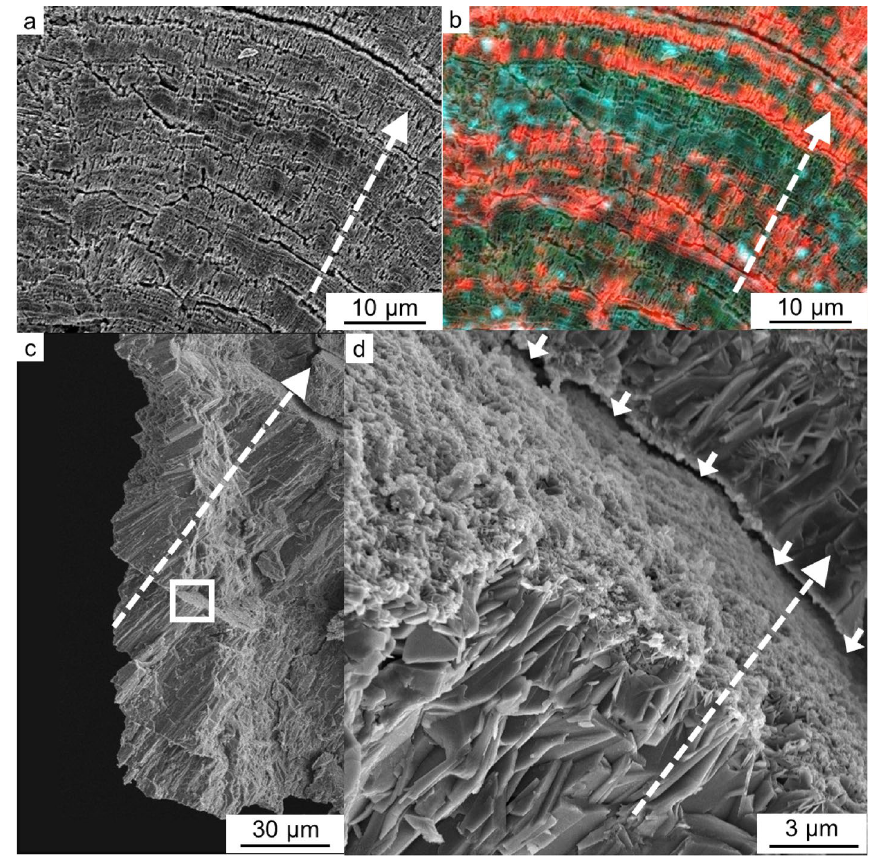
Figure 6. Calgranulin A (Cal-A) distribution in concentric COM. ( a ) Scanning electron microscope (SEM) image of a thin section. ( b ) Merged images of multi-IF staining and SEM of the thin section. The positions of the concentrically aligned gap spaces shown in the SEM image are overlapped with the positions of Cal-A lamination. ( c ) SEM image of a crashed concentric COM. ( d ) Enlarged image of the white box area in ( c ). The directions from the center to the outside of concentric COM stones are shown with dashed white arrows. The gap space between the COM crystals is shown with solid white